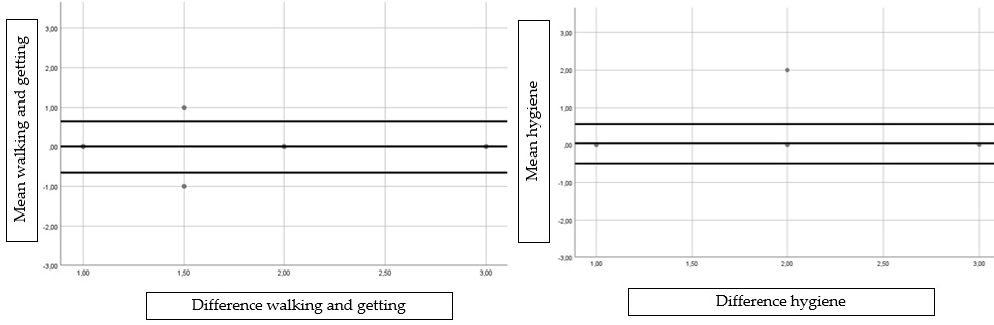
Table 2. Results of reliability, test–retest and systematic differences of the Spanish Podiatry Health Questionnaire (PHQ-S) according to each